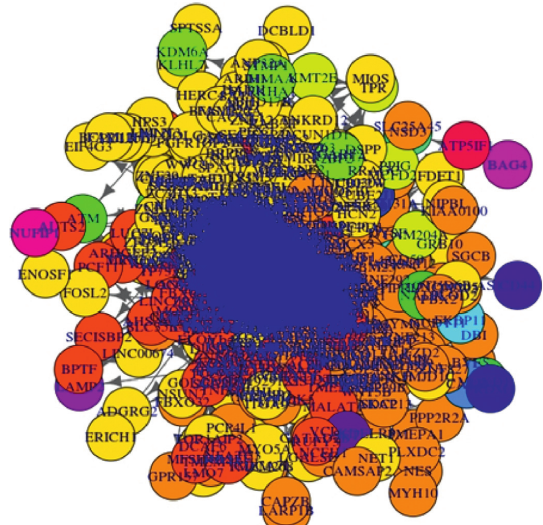
Figure 5: Complex network diagram of TOM gene with threshold λ � 0 . 2186.